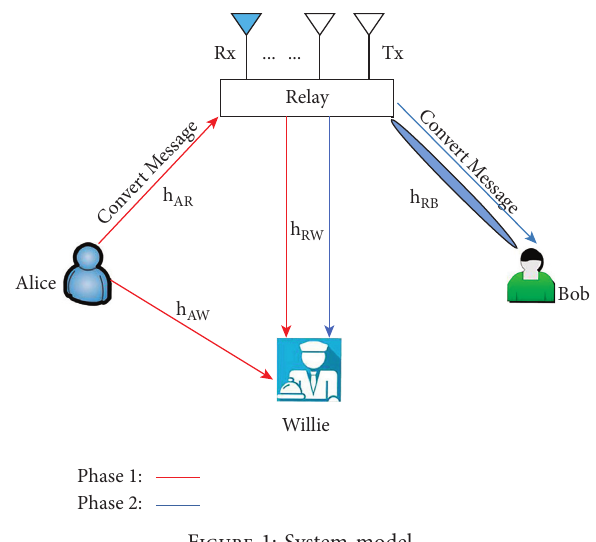
Figure 1: System